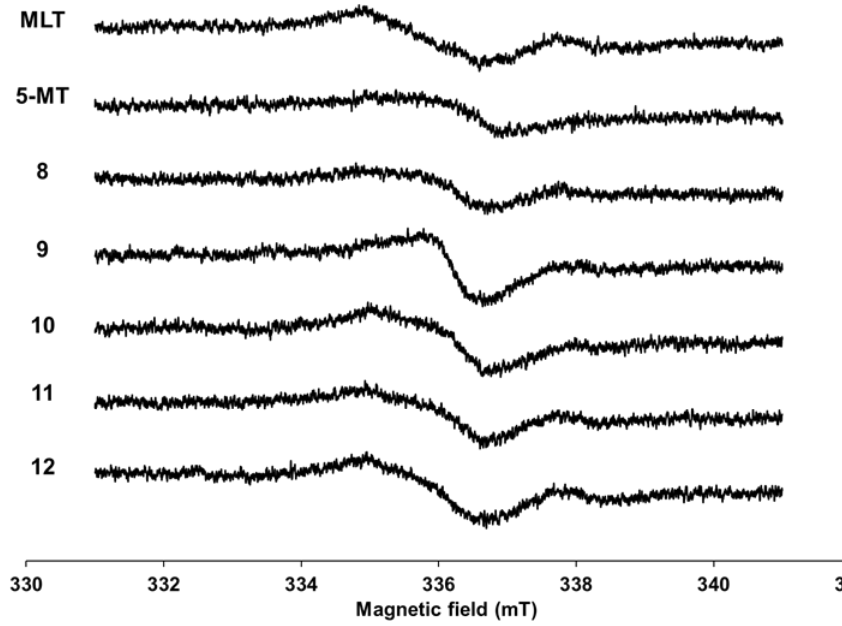
Figure 2. ESR spectra of MLT, 5-MT, and 9 – 13 at a 10 mT sweep width.